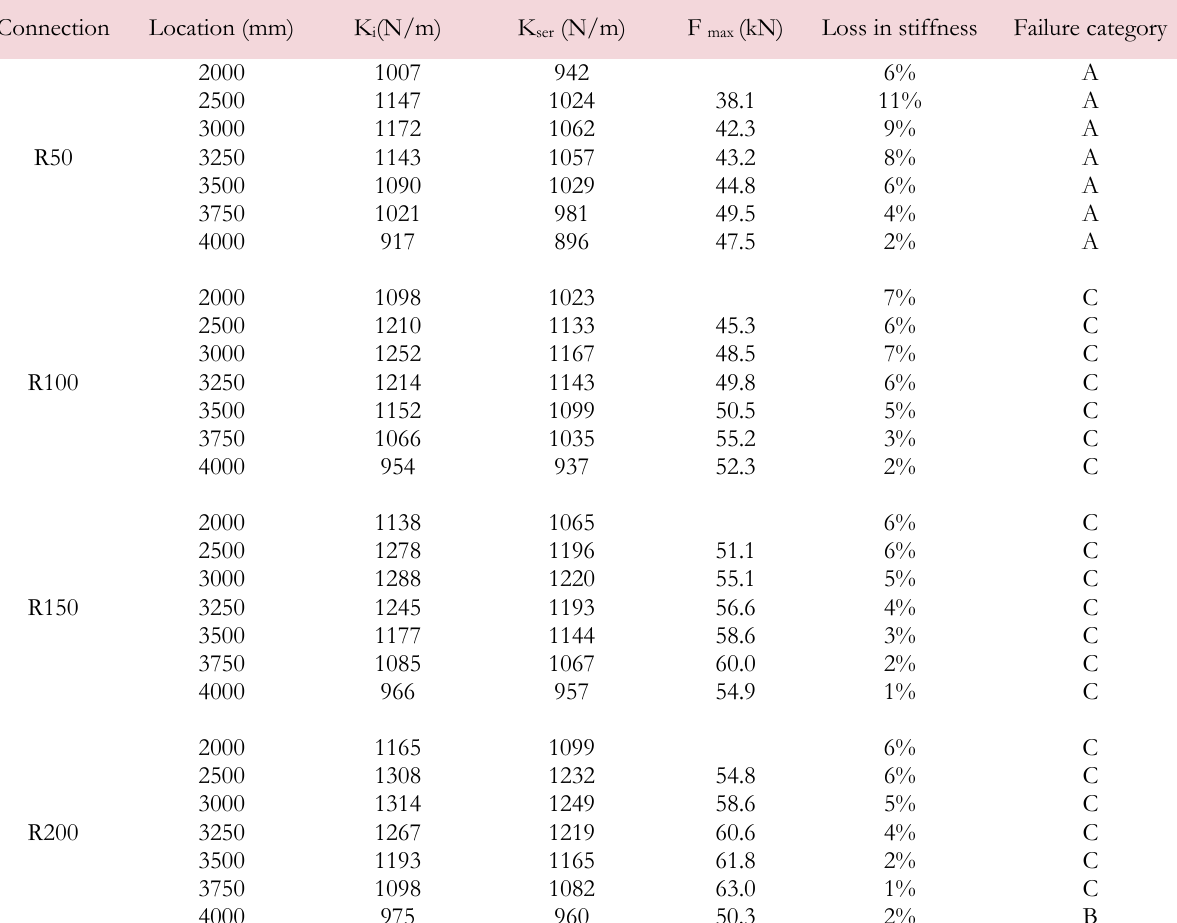
Table 7: The extracted values of initial bending stiffness, elastic strength and ultimate strength. Initial bending stiffness and service bending